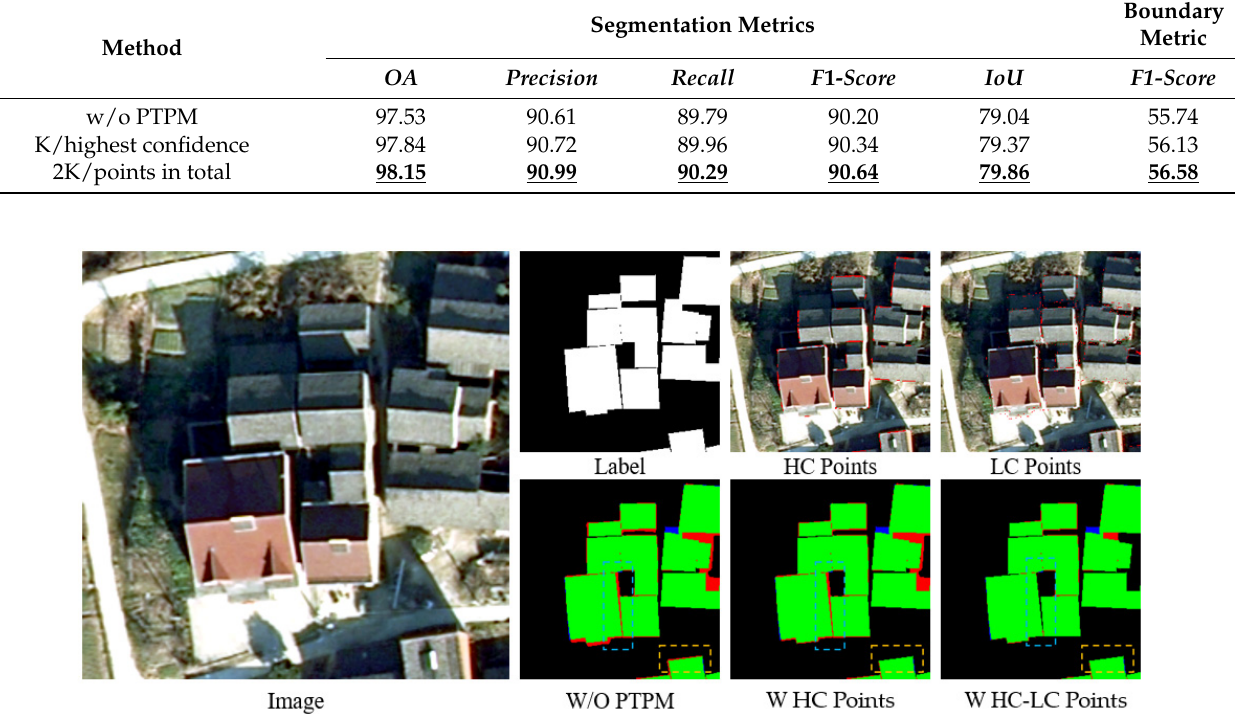
Figure 20. PTPM ablation experiment. The left side is the image, the upper part of the right side represents the results of semantic segmentation in the ablation experiment, and the lower part of the right side represents the results of boundary in the ablation experiment.